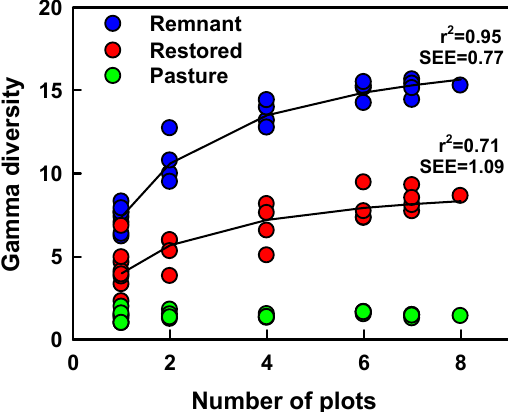
Figure 5. Gamma ( γ ) diversity of random assemblages of plots (each 0.45 m 2 ) sampled in 7 m